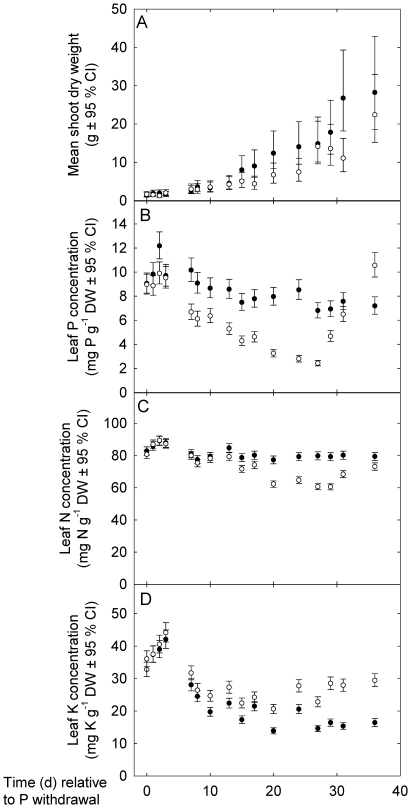
Biomass and macronutrient content of hydroponically grown potato plants.Mean shoot dry weights (A), leaf P concentrations (B), leaf N concentrations (C) and leaf K concentrations of potato plants supplied with a full nutrient solution (closed circles) or supplied with a nutrient solution containing no Pi (open circles). Plants were grown in an NFT hydroponic system under glasshouse conditions. Pi was withdrawn from the nutrient solution supplying half the plants for 28 d before being re-supplied. Data points represent mean ±95% confidence interval (n = 6).